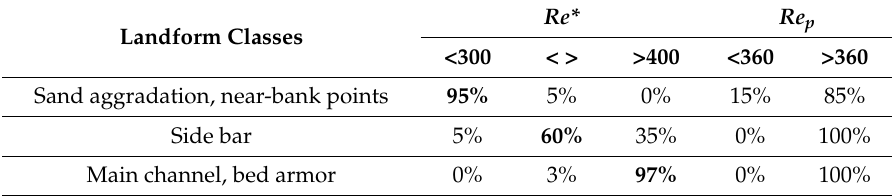
Table 2. Probability values of the shear Reynolds number and the particle Reynolds number, calculated based on the fitted log-normal distribution for grouped